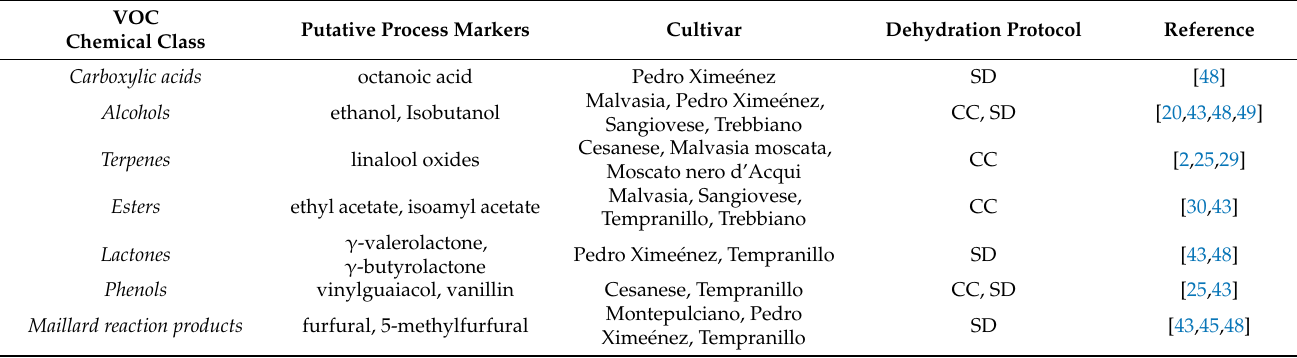
Table 2. Putative VOC markers of dehydration process in wine grape. CC: controlled conditions; SD: sun-drying. VOC Chemical